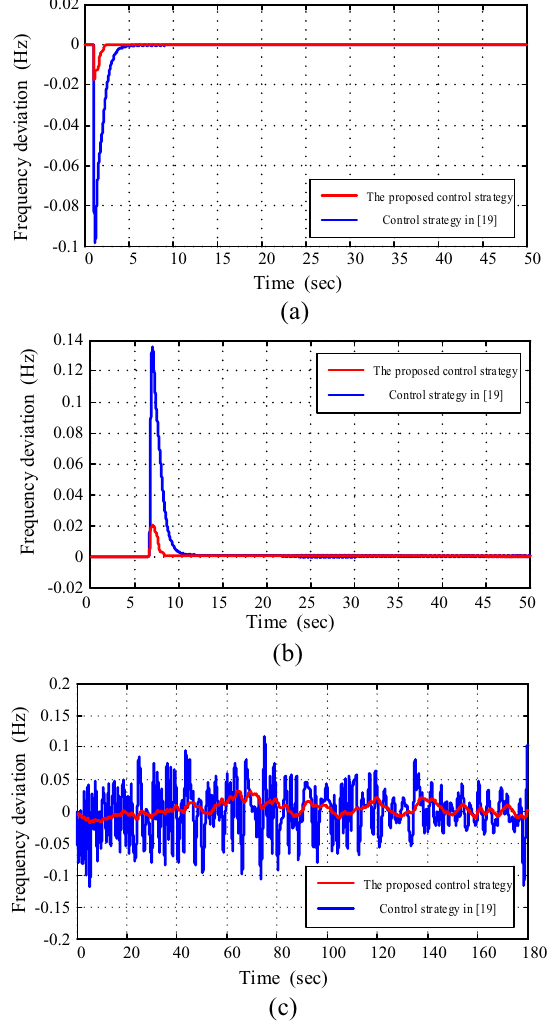
Fig. 13 Simulation results to verify the control strategy, a frequency deviation under the step load fluctuation, b frequency deviation under the step wind speed, c frequency deviation under the random power